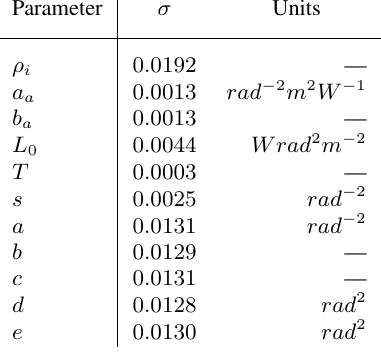
Table 1: Radiometric block adjustment: precision of results. For any image of the block, for each point i , given the colour intensity ( dn i ) and considering all the adjusted parameters, its reflectance ( ρ i ) is computed, for each channel as follows: